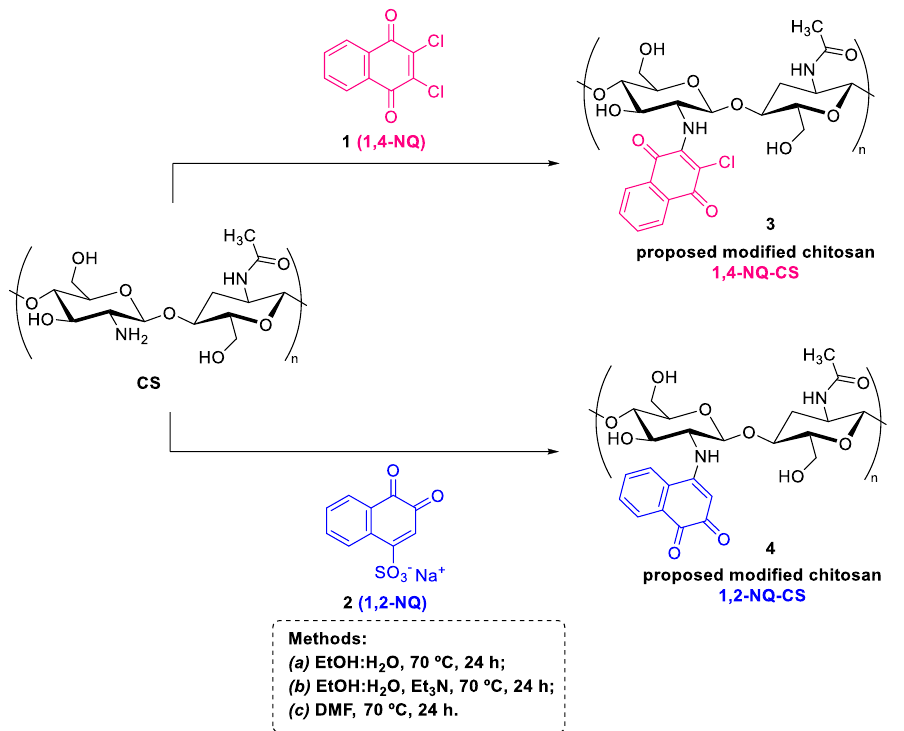
Figure 2. Synthesis of naphthoquinone modified CS using three different methodologies, namely an alcohol/water (EtOH:H 2 O) mixture, alcohol/water (EtOH:H 2 O) plus triethylamine, (Et 3 N) and alcohol/water (EtOH:H 2 O) dimethylformamide (DMF). The reaction took place at 70 °C for 24 h and the mixture was filtered and washed with ethanol, hexane, and anhydrous acetone.